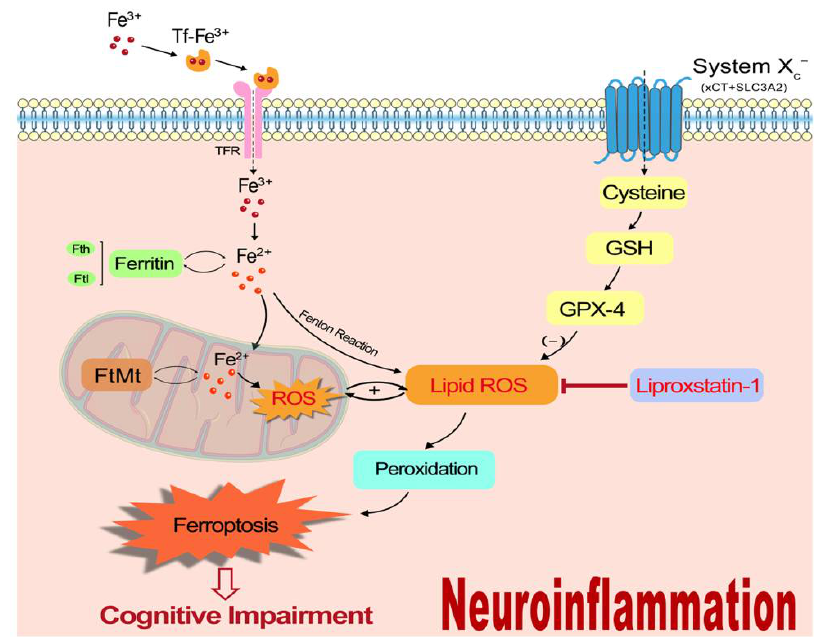
Figure 8. A schematic illustration of the proposed mechanism for ferroptosis to participate in neuroinflammation-induced memory impairment.